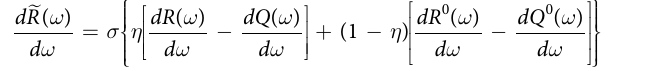
where η is the fraction of the area covered by the AuNRs, and R 0 and Q 0 represent the emission and quenching rates, respectively, of the QDs in the absence of the AuNRs. The details of the calculations are provided in the Supplementary Information along with the relevant refs 25, 26. In agreement with the experimental observation, for a certain range of GaAs thickness, the theoretical calculation indicates enhanced emission intensity in the presence of AuNRs as illustrated in Fig. 3c. Plotting the ratio of the peak intensities with respect to the GaAs thickness, the theoretical enhancement factor peaks at d = 7.5 nm as shown in Fig. 3d, which is in good agreement with the experimental result presented in Fig. 3b. As mentioned above, enhanced electron-hole generation at the AuNR-GaAs interface, carrier diffusion through the bulk GaAs, direct excitation of the InGaAs quantum well and carrier capture by the InAs QDs are suggested as key processes that lead to enhanced photon emission by the QDs. Experimental evidence about the emission enhancement mechanism can be obtained by analyzing the PL intensity dependence on the incident laser power for different thicknesses of GaAs as presented in Fig. 4a–c. For a thickness of 1.5 nm, the intensity is lower in the presence of AuNRs because of the dominance of excitation energy transfer from the QD to the metal